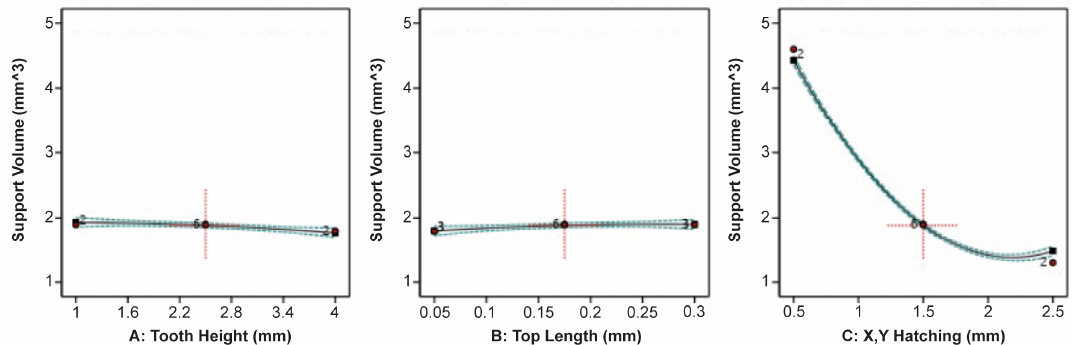
Figure 6. Main plots of Support Volume in Design-Expert 13.